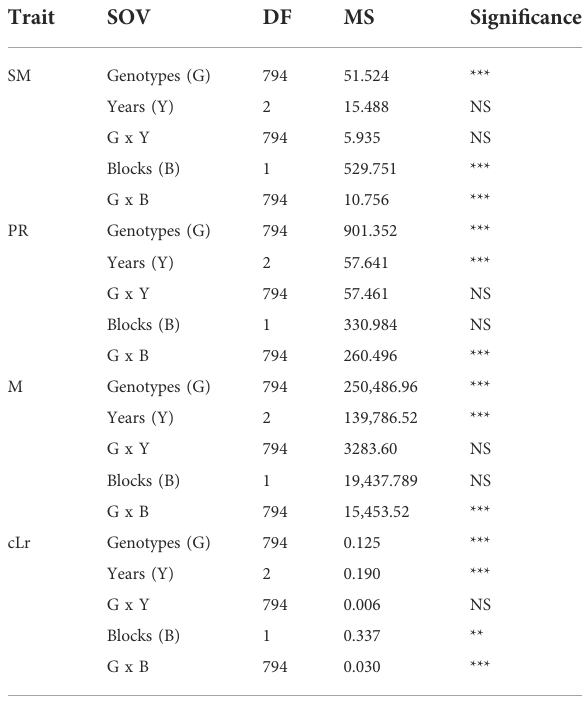
TABLE 2 Analysis of variance among the 795 genotypes of globally diverse population for lodging resistance traits. Trait